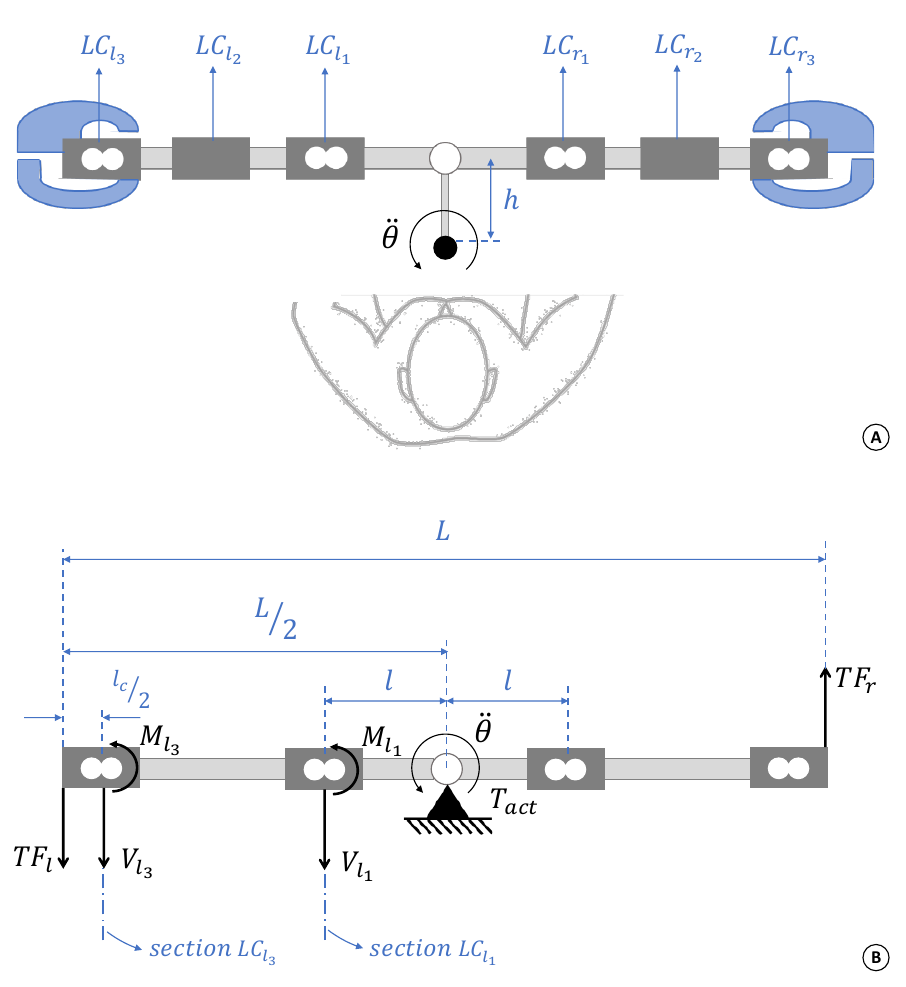
Figure 4. ( A ) Schematic illustration of the handlebar in a top view section. The load cells inside the handles were mounted in a specific way that generates different signals when pushing or pulling the handlebar. ( B ) Free body diagram of the handlebar, showing the two virtual sections used to build the mechanical model of the